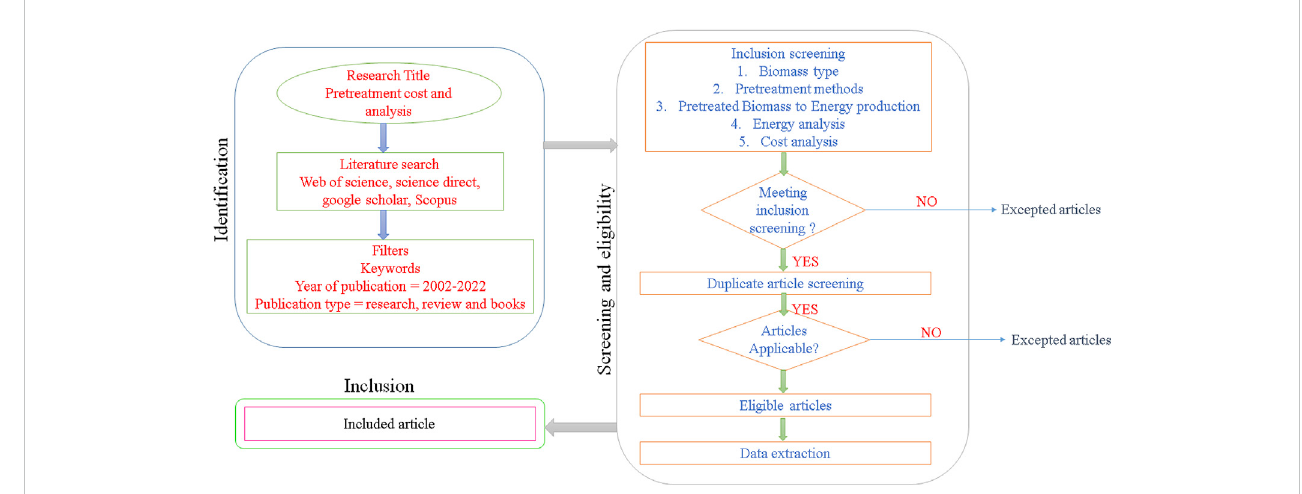
FIGURE 1 Systematic methodology of present literature review.